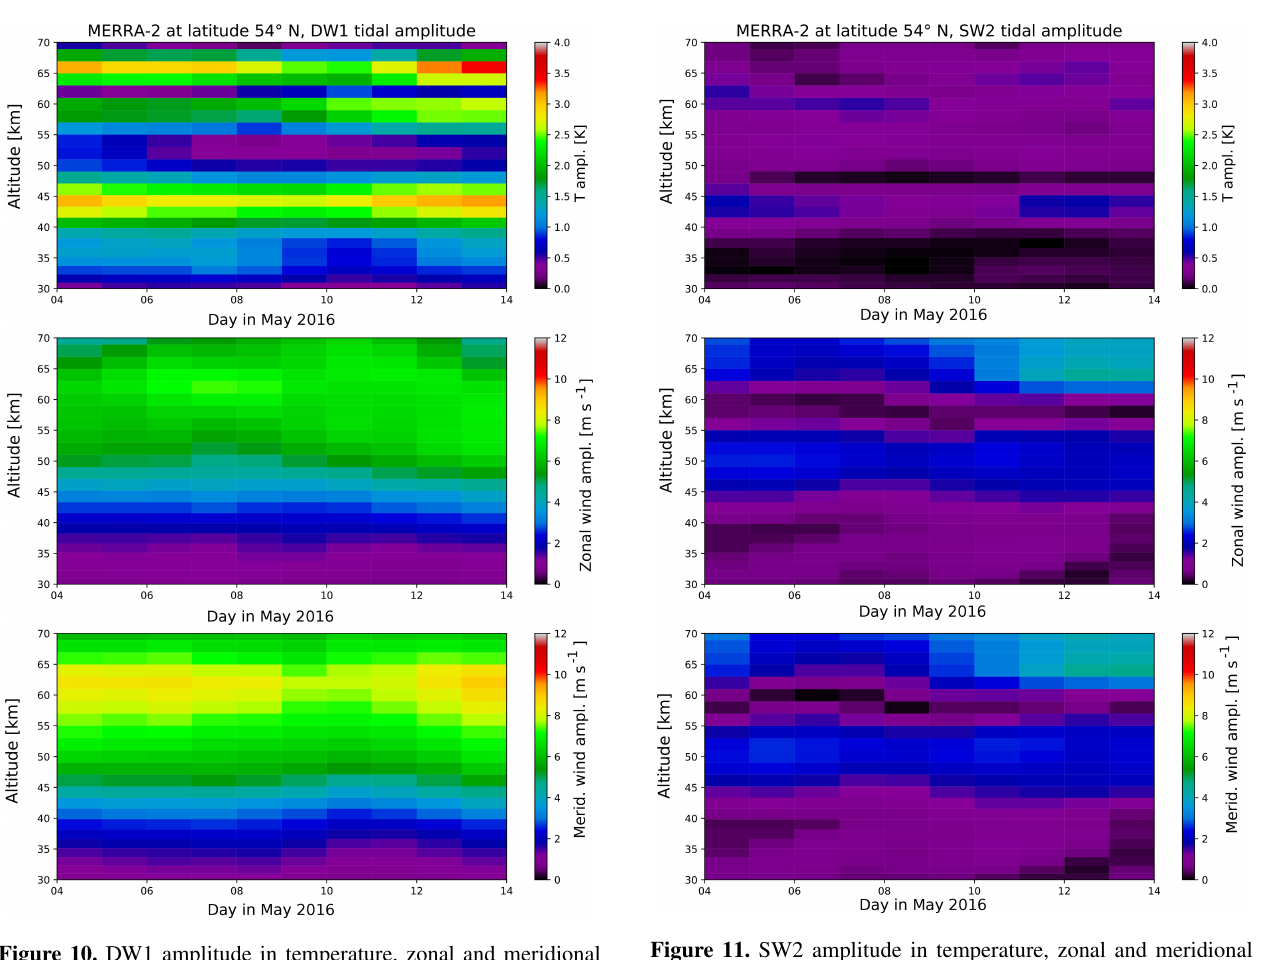
Figure 10. DW1 amplitude in temperature, zonal and meridional wind from global MERRA-2 fields at the latitude of 54 ◦ N.